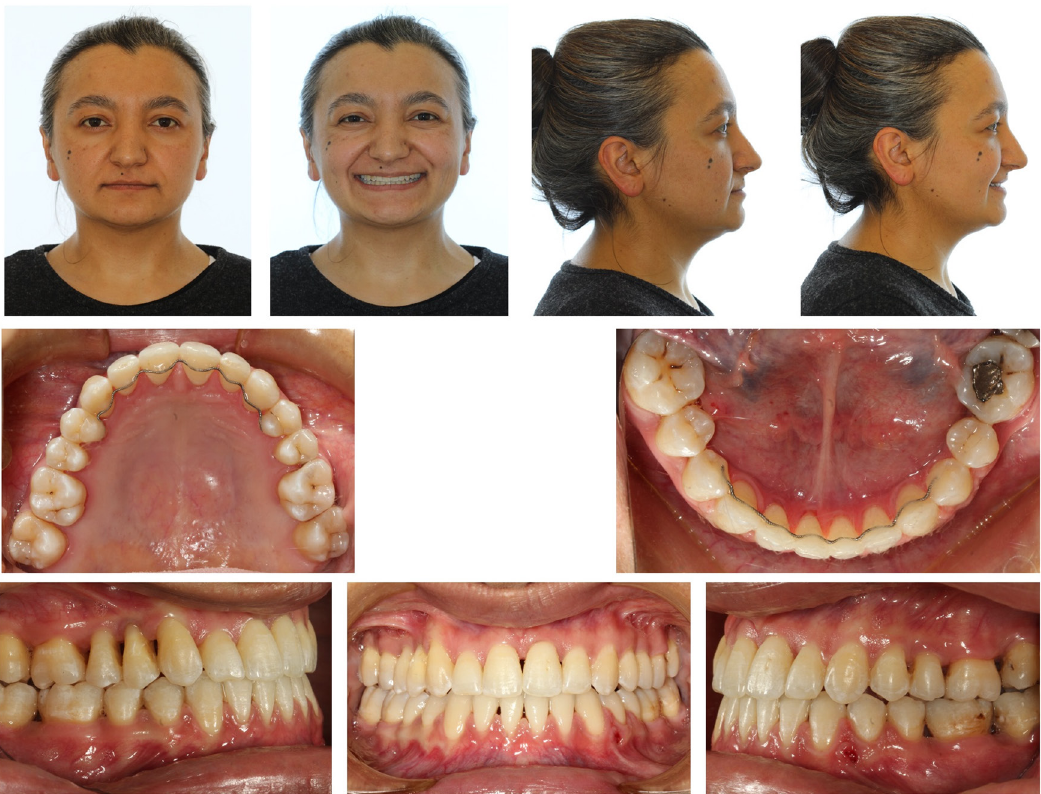
Figure 6. Posttreatment extraoral and intraoral